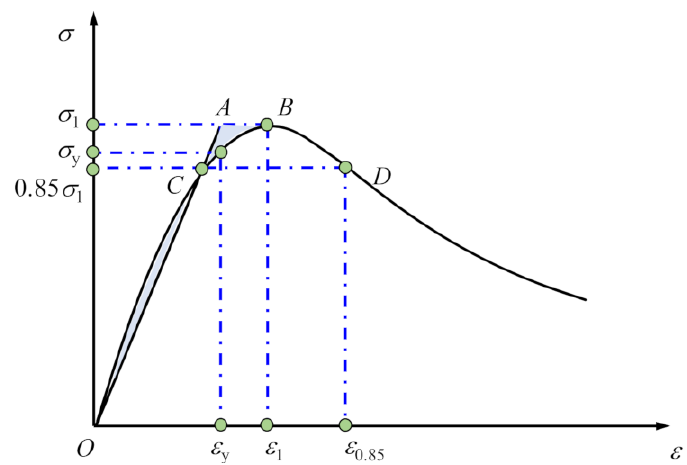
Figure 10. Diagram showing the calculation of strain ductility coefficient.